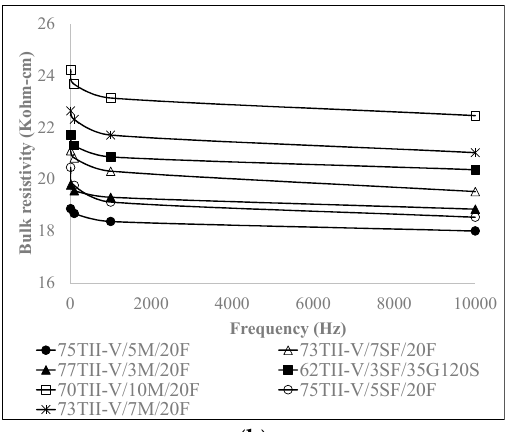
Figure 2. Influence of geometric size at ( a ) 10 kHz, ( b ) 1 kHz, ( c ) 0.1 kHz and ( d ) 0.01 kHz. The I-shaped line parallel to the y-axis is called an error bar. The point at the center of the line represents the mean of the ratios. The portion of the line from that point to the bottom and top represents the standard deviation of the ratios for nineteen mixtures.